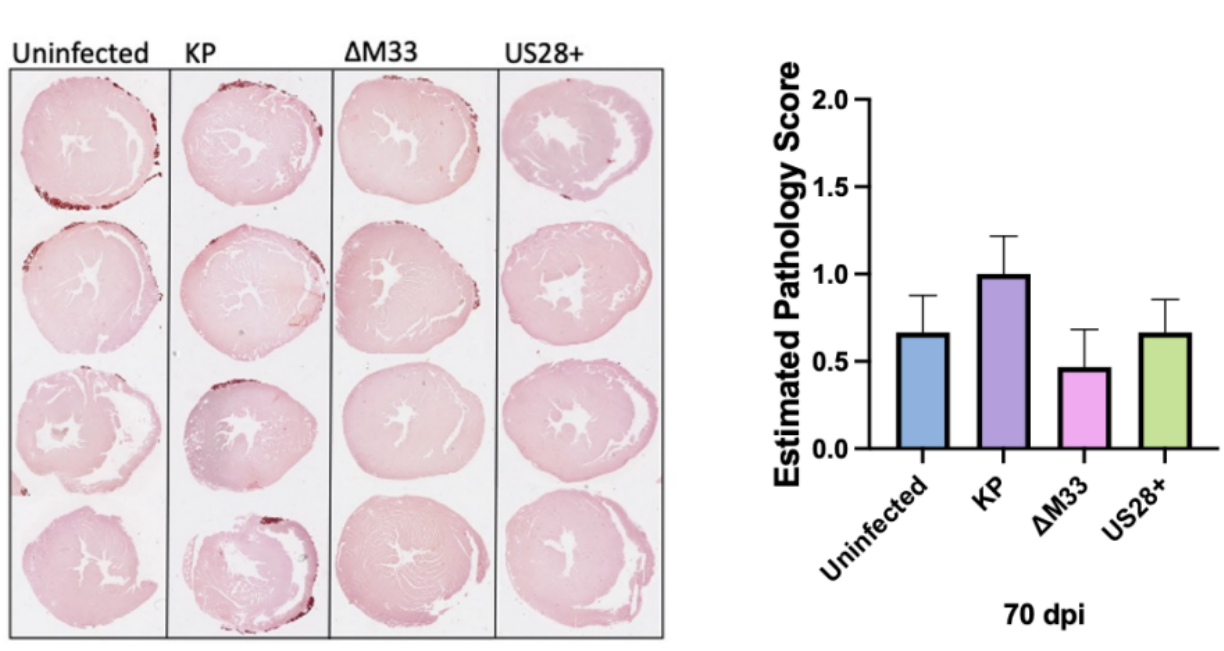
Figure 4. MCMV-induced calcification during latent infection. Animals were uninfected or infected with 1 × 10 6 PFU by i.p. inoculation. At 70 dpi, ( A ) hearts were stained with Alizarin red solution to evaluate calcification in duplicate ( n = 4). ( B ) Hearts were scored on the basis of the estimated pathology on the outer epicardium, as previously described. Studies were conducted in triplicate ( n = 15).